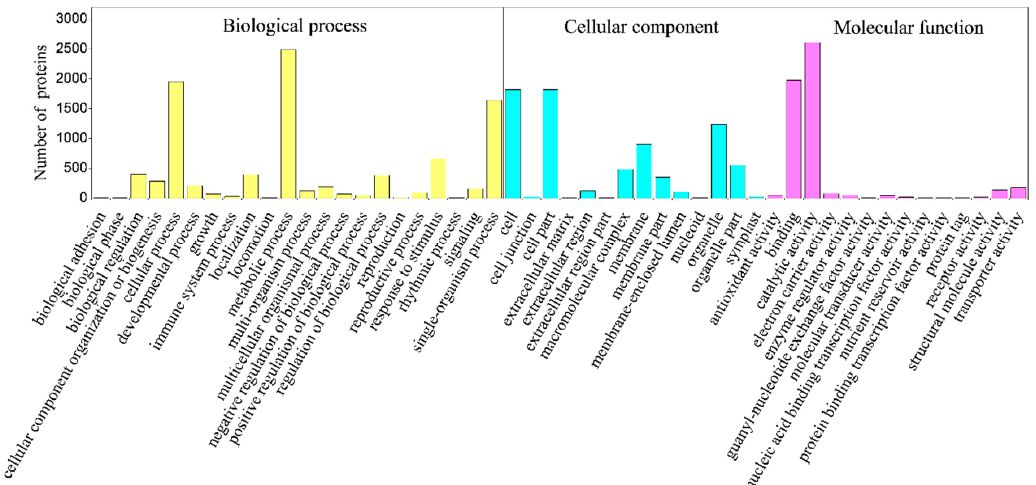
Figure 4. Gene Ontology (GO) analysis of differently expressed proteins (DEPs) in IBA-treated apple cuttings, compared with untreated controls. Expressed proteins involved in molecular function, cellular component and biological process against the GO database. The X axis represents the Gene Ontology functional classification; The Y axis represents the number of differentially expressed proteins.